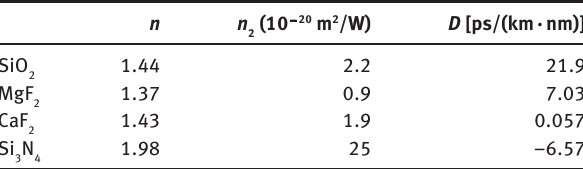
Table 2: Comparison of resonator material properties at 1550 nm. n